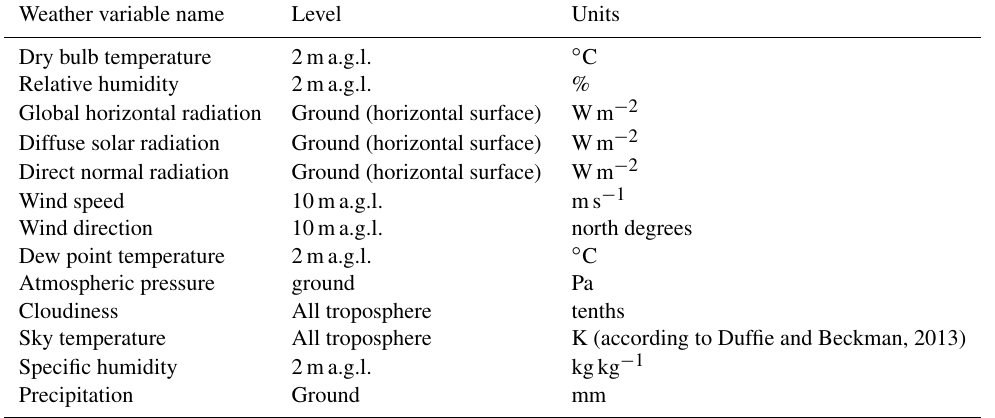
Table 2. Name, level, and units of all weather variables used in the produced weather